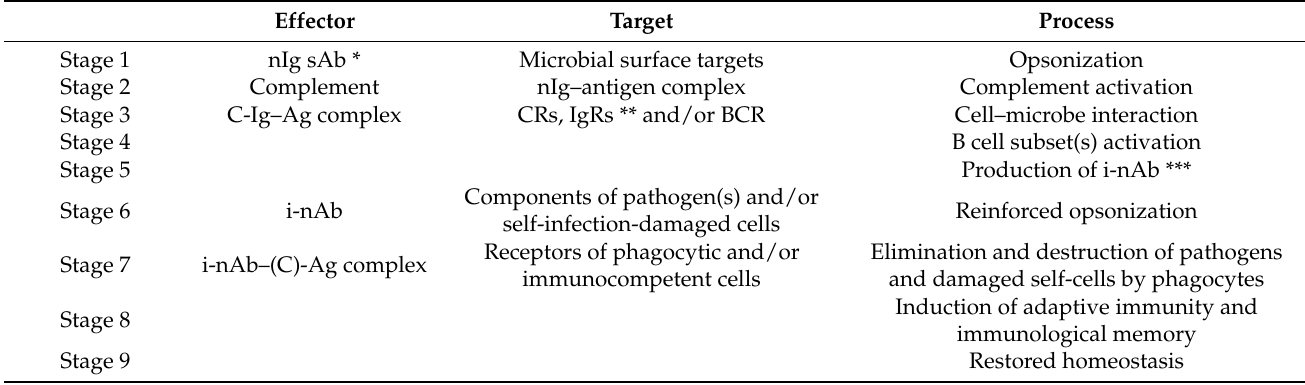
Table 1. Possible stages of infection-induced natural antibodies involvement in homeostasis restoration after infection. * nIg sAb—natural IgM soluble antibodies, ** IgRs—immunoglobulin receptors, *** i-nAb—infection-induced early (natural)